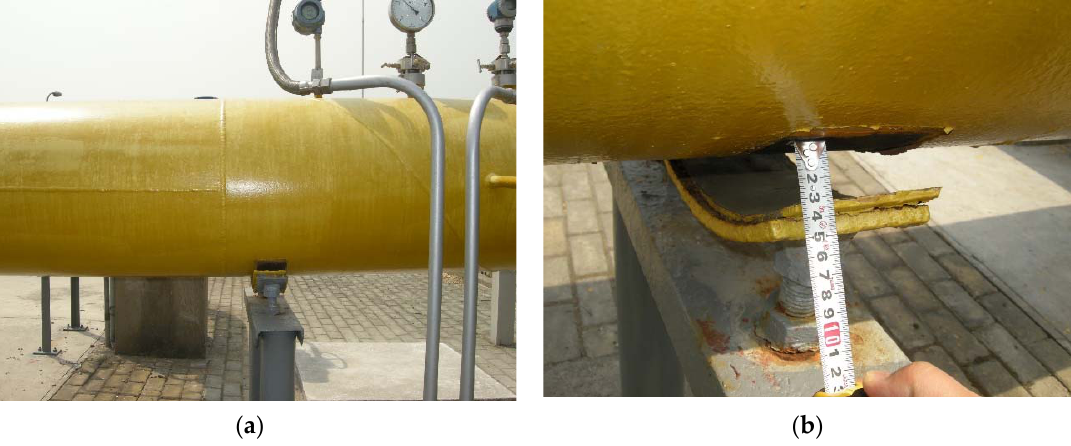
Figure 4. Diagram of pipe breakaway support on the site: ( a ) general view of the pipe disconnect-